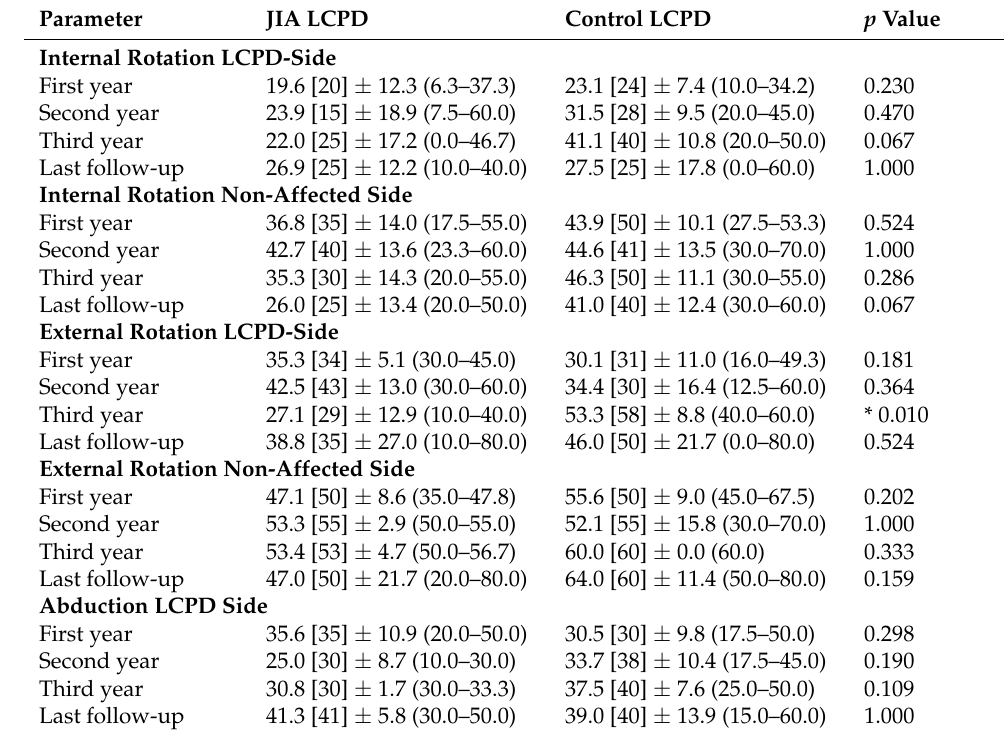
Table 6. Motion in the course of treatment for the two study